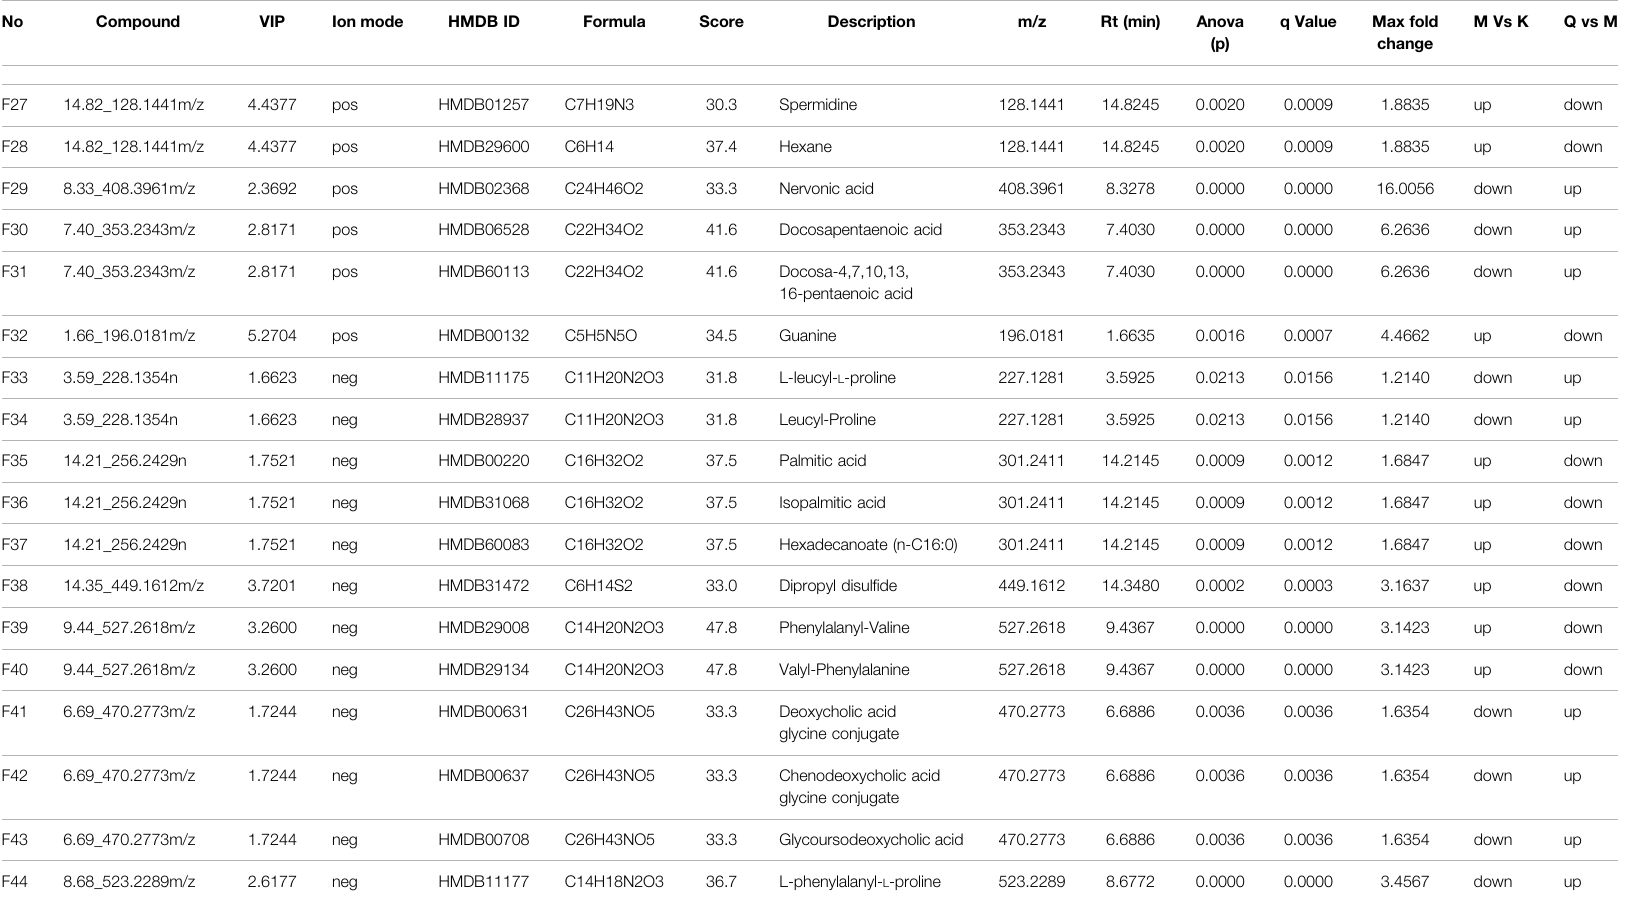
F represents feces. K represents control group, M represents model group, Q represents R. Scrophulariae